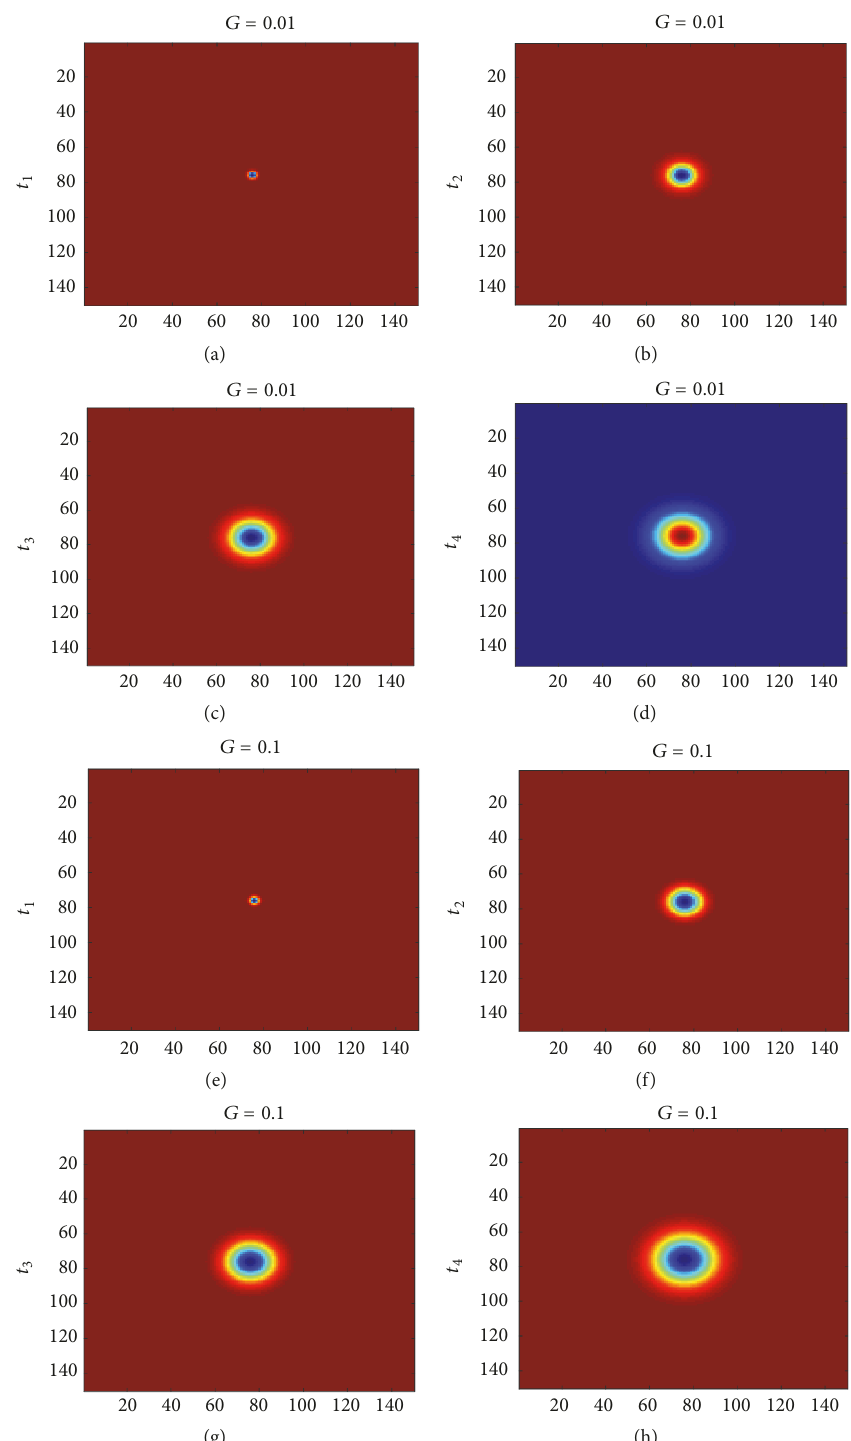
Figure 20: The snapshots of spatial distribution of membrane potential with color scale for neurons in the square array network for 𝑘 = 1 and 𝐷 = 1 at 𝑡 1 = 2 time units, 𝑡 2 = 75 time units, 𝑡 3 = 170 time units, and 𝑡 4 = 300 time units. ((a)–(d)) 𝐺 = 0.01 and ((e)–(h)) 𝐺 = 0.1